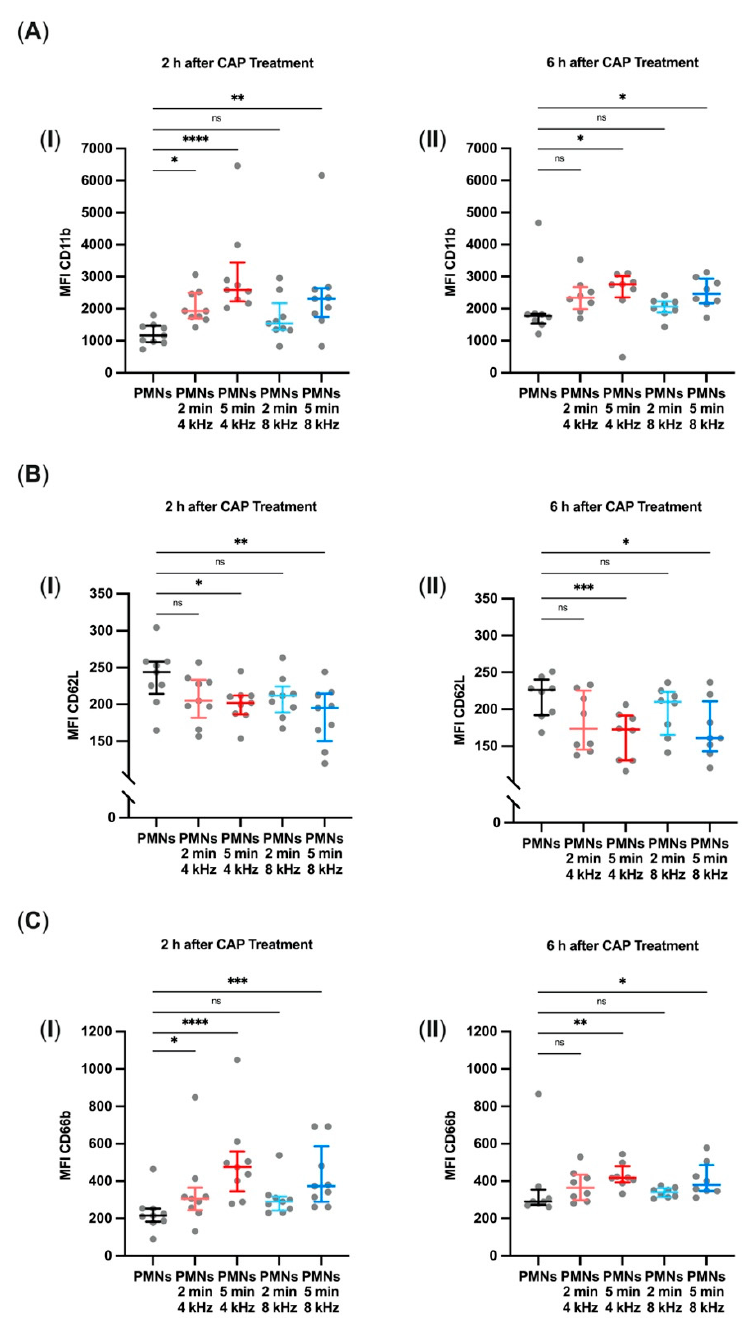
Figure 6. Promoted integrin and selectin expression on PMN surfaces. Flow cytometric measurement of the median fluorescence intensity (MFI) of ( A , I , II ) CD11b, ( B , I , II ) CD62L, and ( C , I , II ) CD66b 2 h ( n = 9) and 6 h ( n = 8) after CAP treatment with 4 kHz or 8 kHz for 2 min and 5 min. Statistical analysis: Friedman test. * p < 0.05, ** p < 0.01, *** p < 0.001, **** p < 0.0001, ns: not significant.